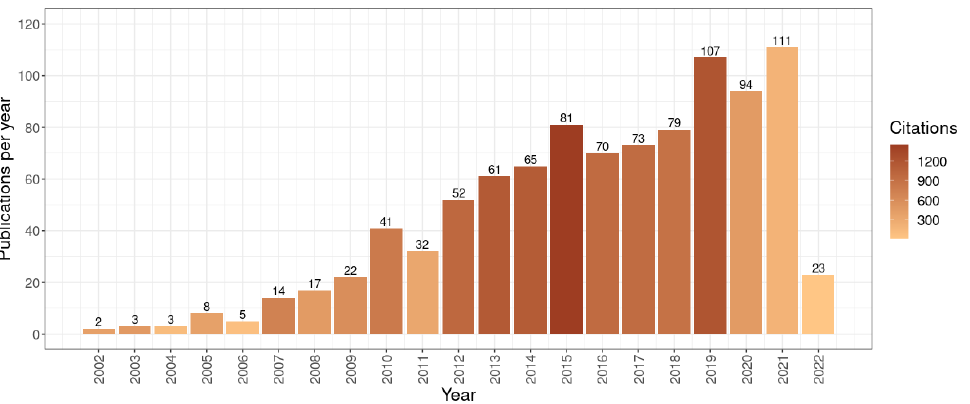
Figure 2. Yearly distribution of articles on hyper-heuristics between 2002 and 2022 (obtained on 5 April